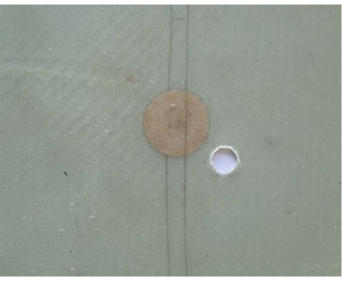
Figure 3. Smart PMC plate with a 10 mm diameter hole. Table 1. The configuration of the 9 tested plates.